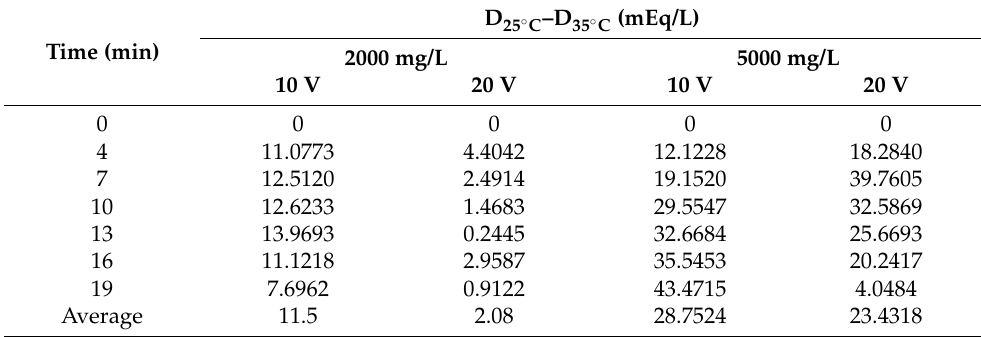
Table 6. Differences between the diluate stream concentrations in the 25 and 35 ◦ C tests.